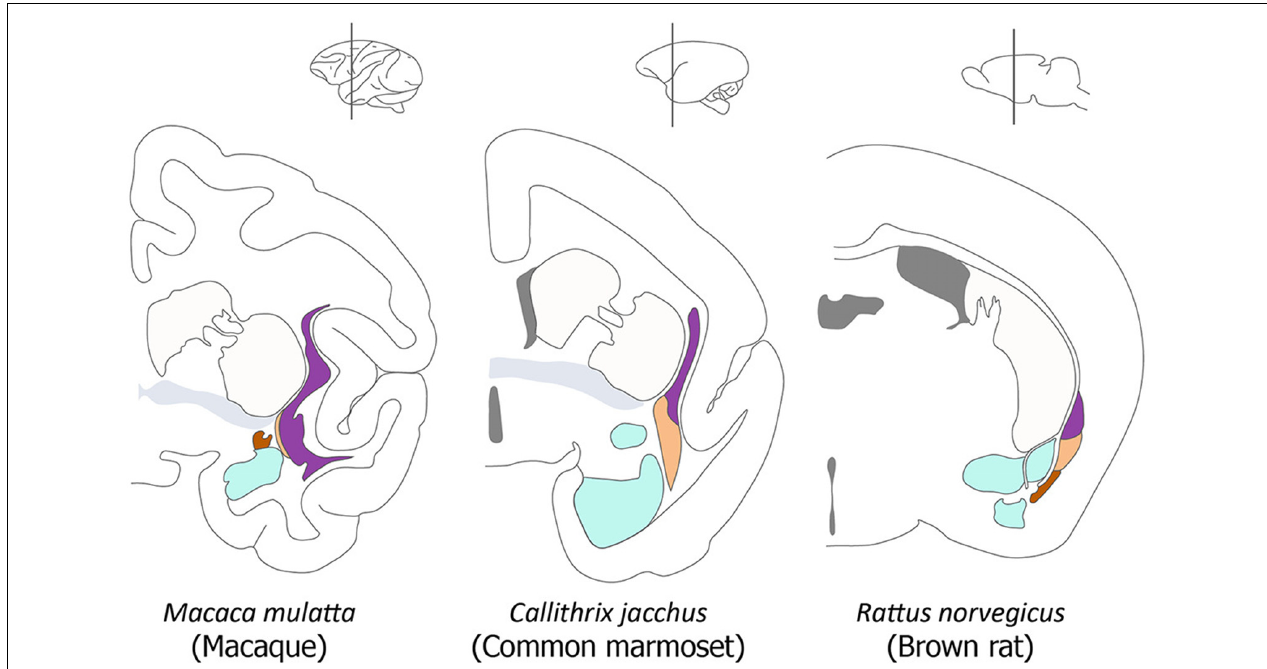
FIGURE 1 | Organization of the claustrum in the macaque, marmoset and rat. A series of diagrams of coronal sections of primate and rodent brains to illustrate the commonly accepted view of the relative size and position of the components of the claustrum and their relationship to neighboring structures. In each diagram the principal claustrum is colored purple, the dorsal endopiriform nucleus (DEn) is colored beige, the ventral endopiriform nucleus is colored brown, the amygdala is colored cyan, the anterior commissure is colored gray, and the caudate-putamen and cortex are not colored. This diagram is adapted from Figure 1 in Smith et al.